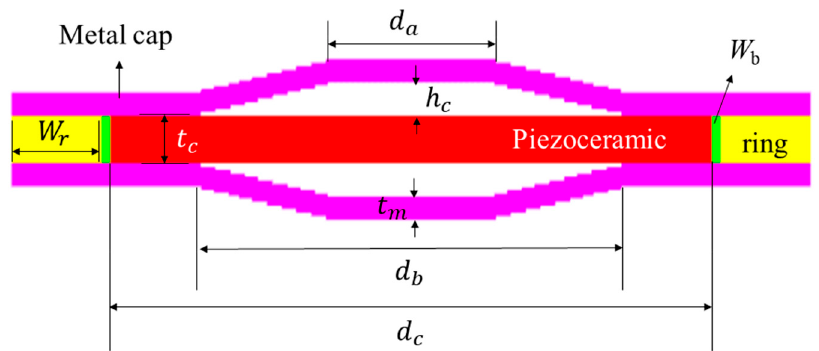
Figure 1. Schematic structure of the cymbal transducer.